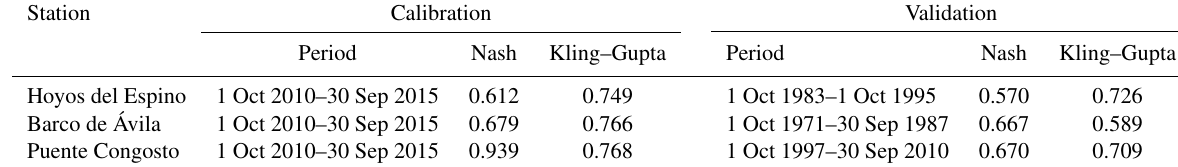
Table 3. Calibration and validation results for the gauging stations upstream of the Santa Teresa dam.